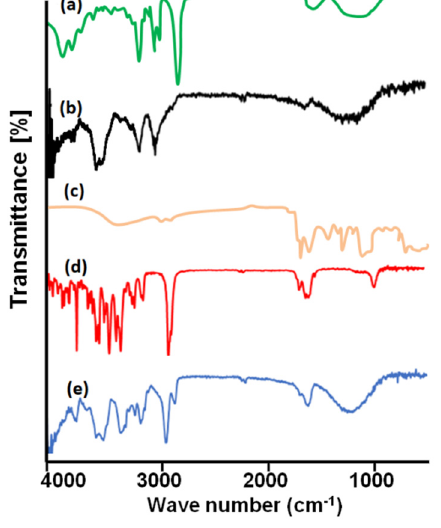
Figure 5. FTIR Spectra of ( a ) PVP-K30, ( b ) PVA ( c ) Thiolated Chitosan, ( d ) Simvastatin and ( e ) Simvastatin loaded dMNP. Table 3. FTIR peaks and corresponding functional